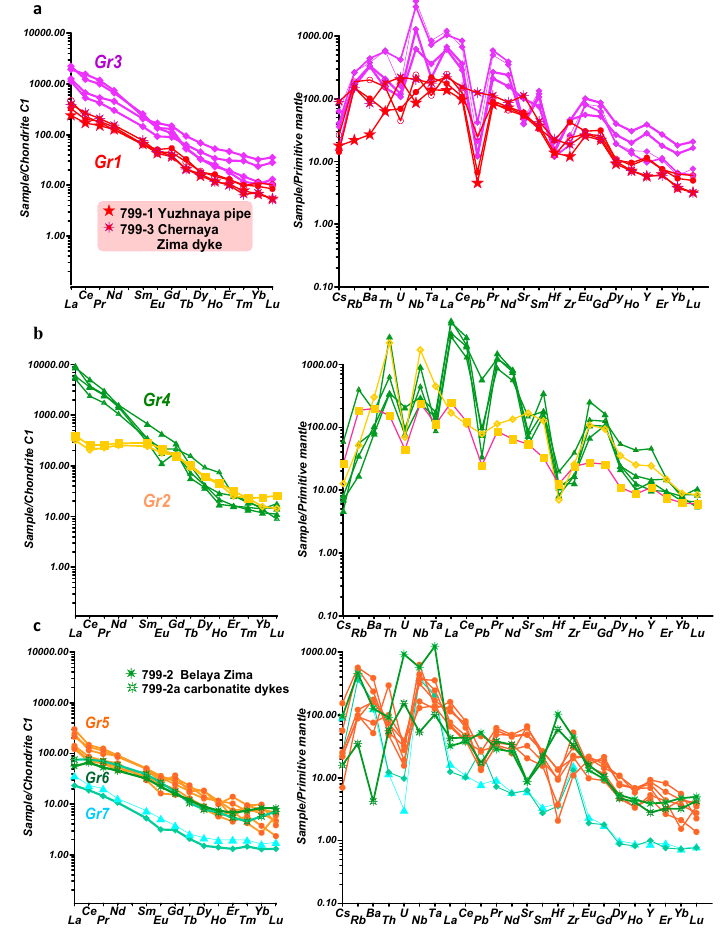
Figure 12. REE and TRE spectra of bulk composition of aillikites and carbonatites from BZM. Aillikites outside massif ( a ), aillkites in BZM ( b ), Phl carbonatities and aillikites ( c ). Normalized to primitive mantle [62] and chondrite C1.